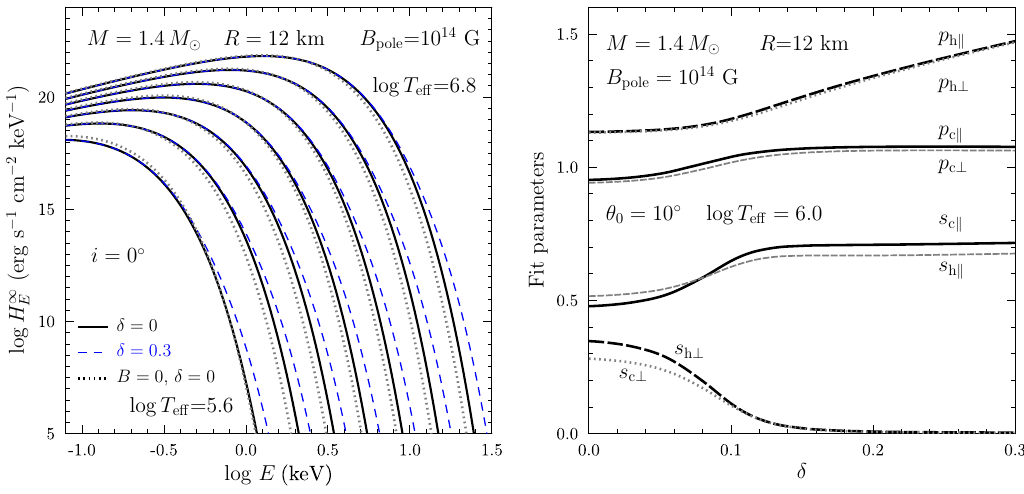
Figure 6. ( Left ): Thermal spectral fluxes observed from magnetic poles of a neutron star with M = 1.4 M at B pole = 10 14 G and log T eff [K]= 5.6, 5.8,...,6.6. The solid lines are obtained without extra heating, while the dashed lines are for two extra hotspots of angular size ϑ 0 = 10 ◦ on magnetic poles at the heating parameter δ = 0.3. Dots show 1BB model for a non-magnetic star to guide the eye. ( Right ): 2BB fit parameters for the same star with T eff = 1 MK possessing two polar hotspots of angular size ϑ 0 = 10 ◦ on magnetic poles [see Equation (8)] versus extra relative surface temperature increase δ at the